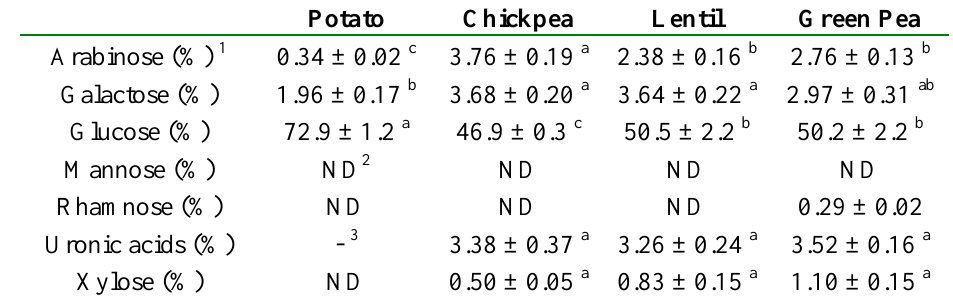
Table 2. Sugar composition of total carbohydrates expressed as a percentage of dried treatment